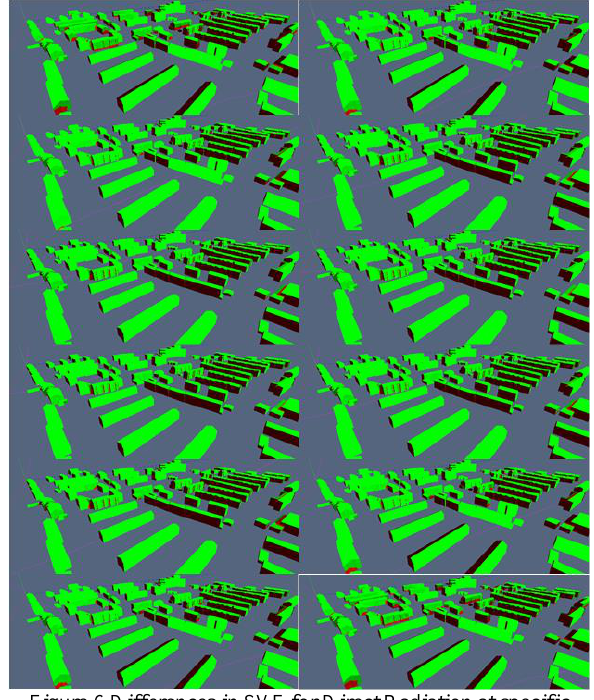
Figure 6 Differences in SVF for Direct Radiation at specific time of each month.